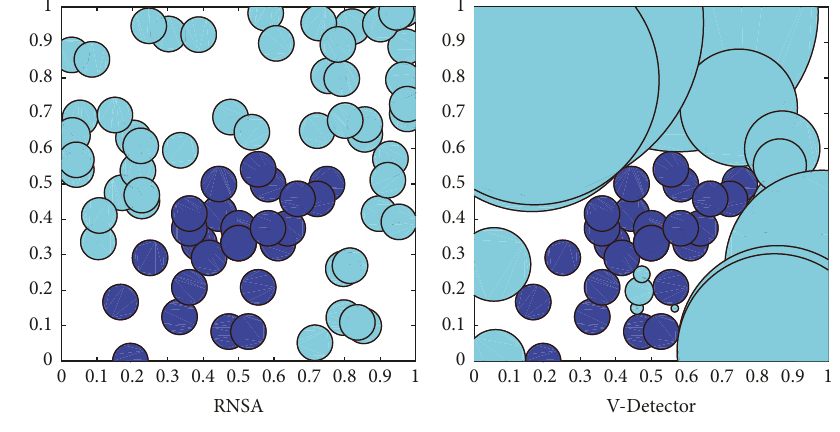
Figure 5: Contrast of RNSA and V-Detector.